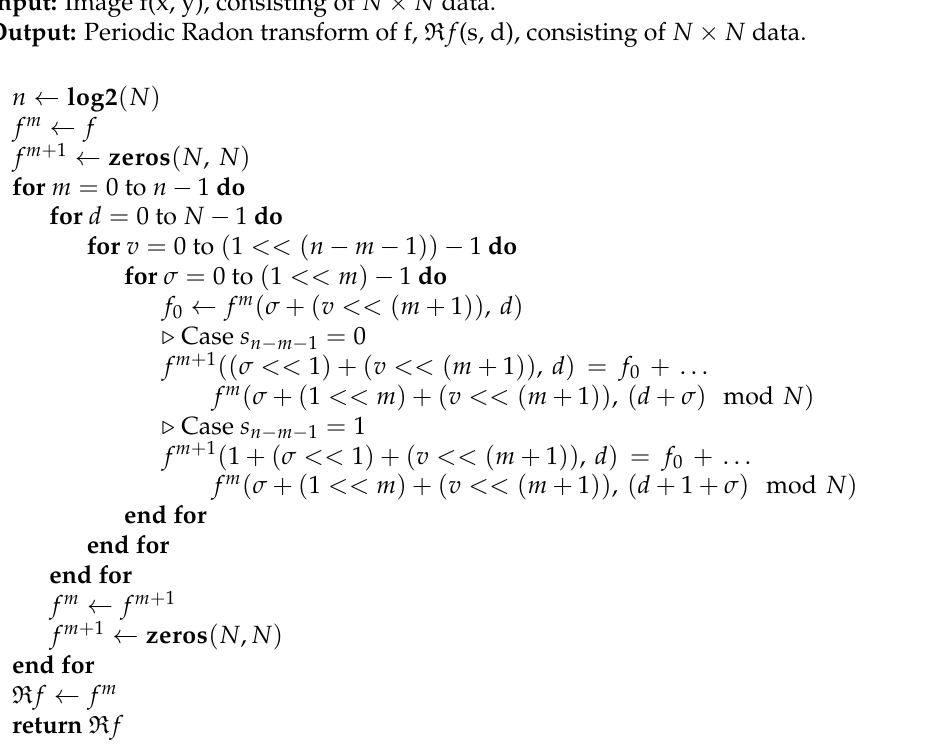
Algorithm A2 Compute the periodic DRT of a